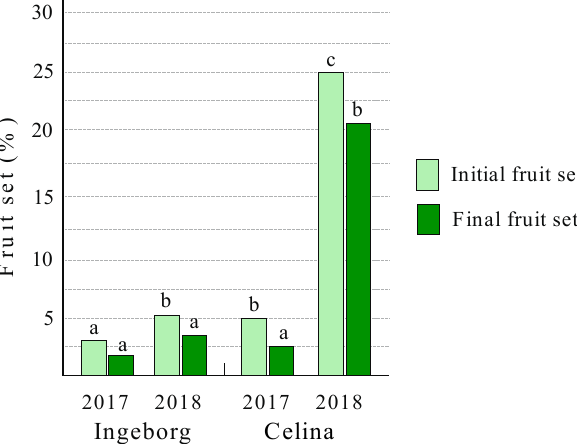
Figure 7. Fruit set in pear cultivars ‘Ingeborg’ and ‘Celina’ in open-pollination combination, during 2017 and 2018. Different letters above the bars denote a significant difference between the cultivars (for each trait studied) according to the LSD test, p < 0.05.